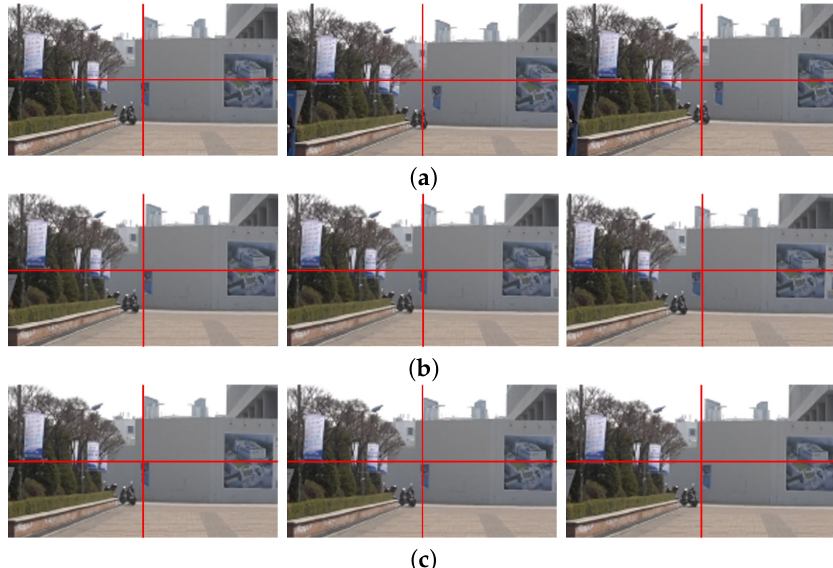
Figure 14. Experimental results of various camera path smoothing methods: ( a ) the enlarged shaky video frames (275th, 276th, and 277th frames), ( b ) the stabilized video using a moving average filter [7], and ( c ) the proposed video stabilization